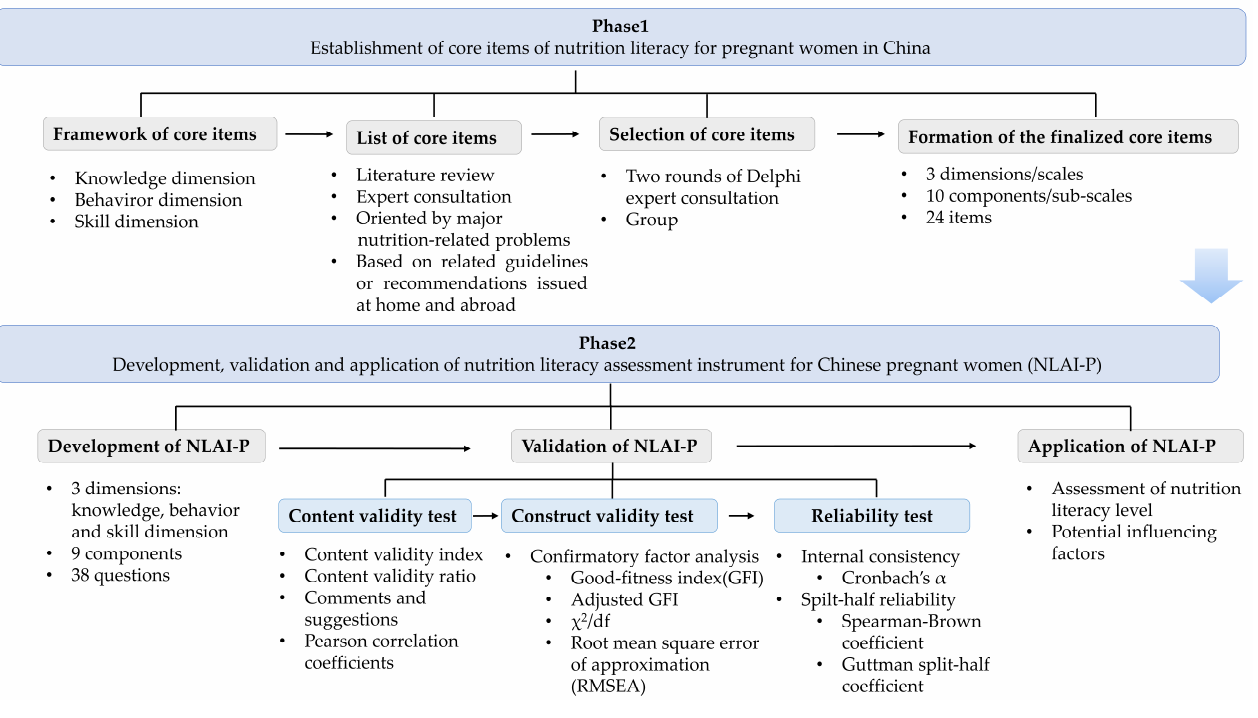
Figure 1. The flow chart of the study on the development, validation and application of nutrition literacy assessment for Chinese pregnant women (NLAI-P). Table 1. The core items of nutrition literacy for pregnant women in China.